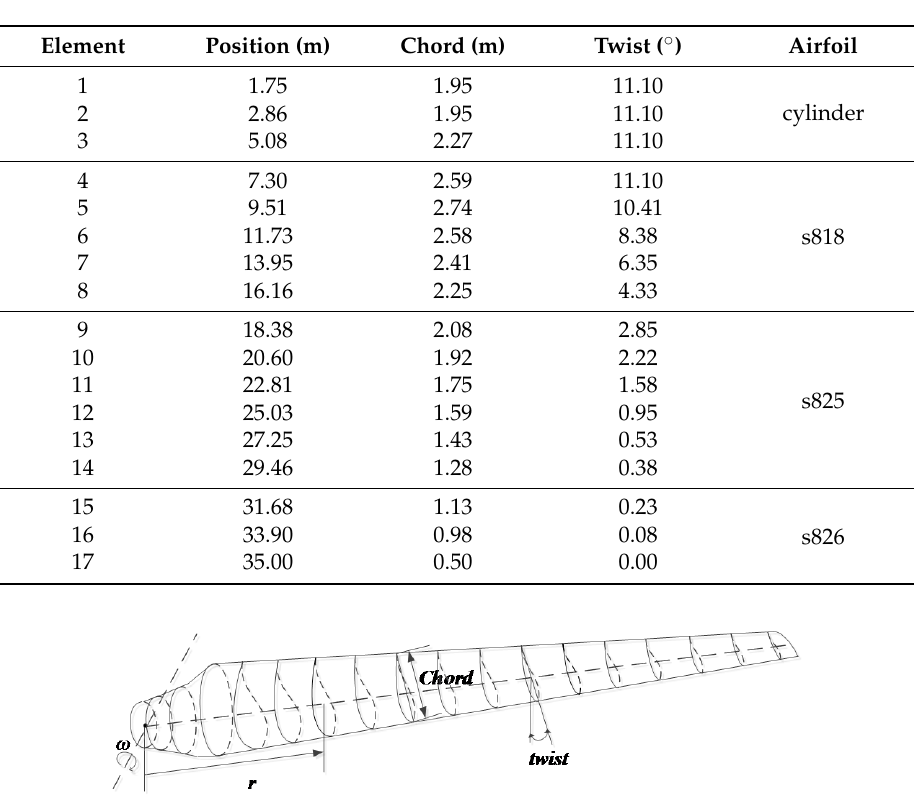
Table 1. Geometry of the National Renewable Energy Laboratory (NREL) 1.5 MW wind turbine blade.